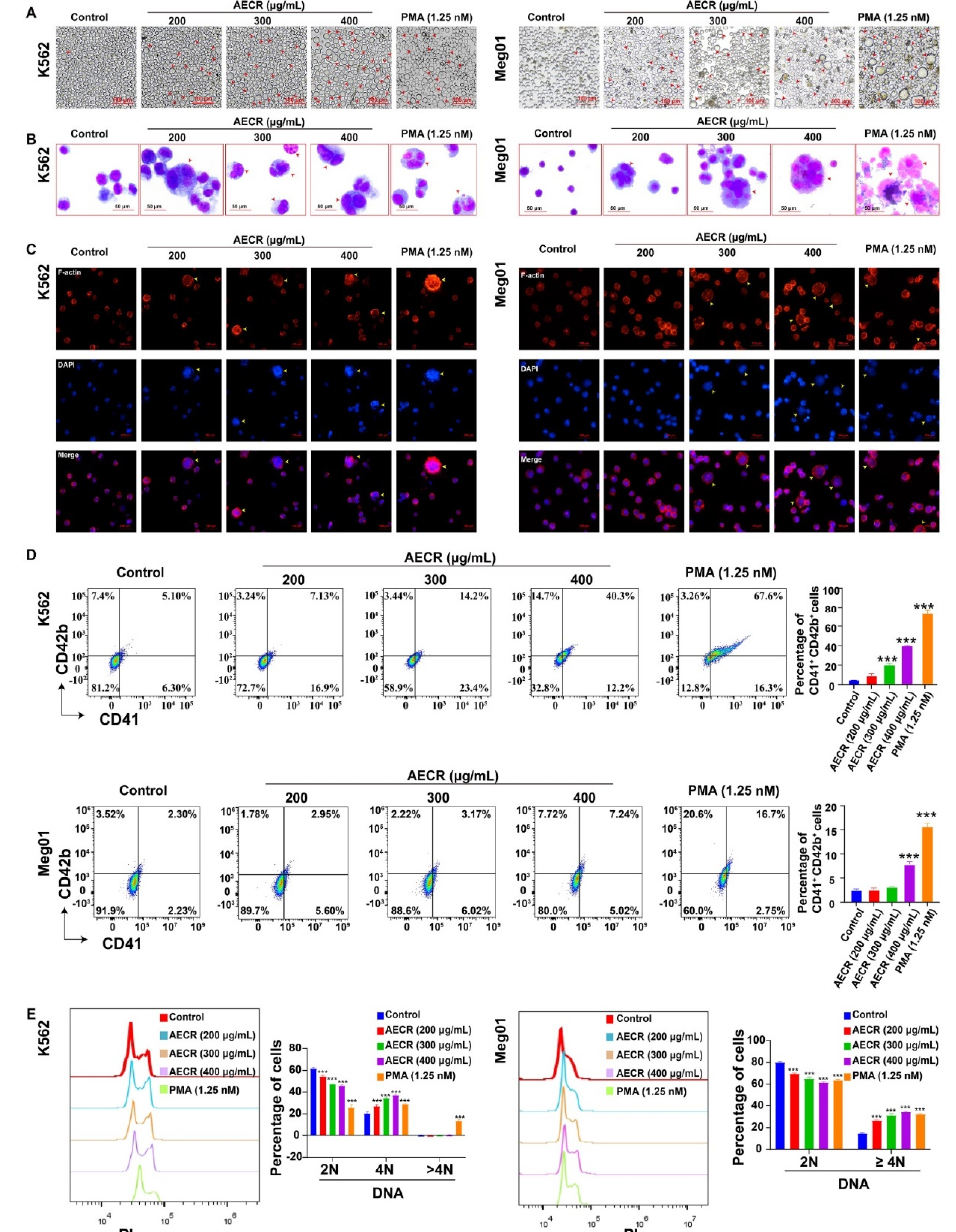
Figure 3. AECRs induce K562 and Meg01 cell differentiation and maturation. ( A ) Representative images show that cell size is increased after 4 days of AECR and PMA intervention (red arrowheads). ( B ) Cells stained with Giemsa showed large and numerous nuclei upon PMA or AECR treatment for 4 days (red arrowheads). ( C ) Cells stained with phalloidin showed the enhanced expression of F-actin upon PMA or AECR treatment for 4 days. ( D ) The CD41 and CD42b expression levels were analyzed by flow cytometry after 4 days of treatment with AECRs and PMA. On the right, this statistical histogram displays CD41 + CD42b + cell proportions. The values represent the means ± standard deviations (n = 3). ( E ) After the cells were treated with AECRs for 4 days, the cells with PI staining were used to analyze DNA content (2, 4, and >4N) by flow cytometry. On the right, this statistical histogram displays cell proportions. The values represent the means ± standard deviations (n = 3). *** p < 0.001 versus the control group. AECRs: aqueous extracts of Cibotii rhizoma ; PMA: phorbol ‐ 12 ‐ myristate ‐ 13 ‐ acetate.